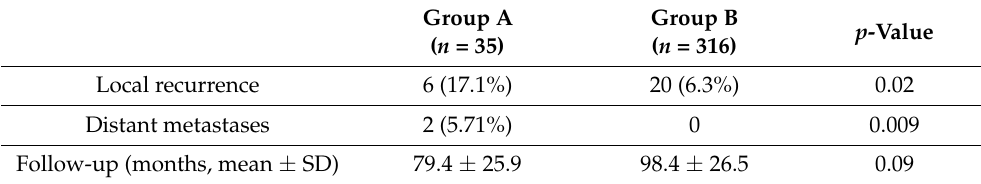
Table 5. Local recurrence and distant